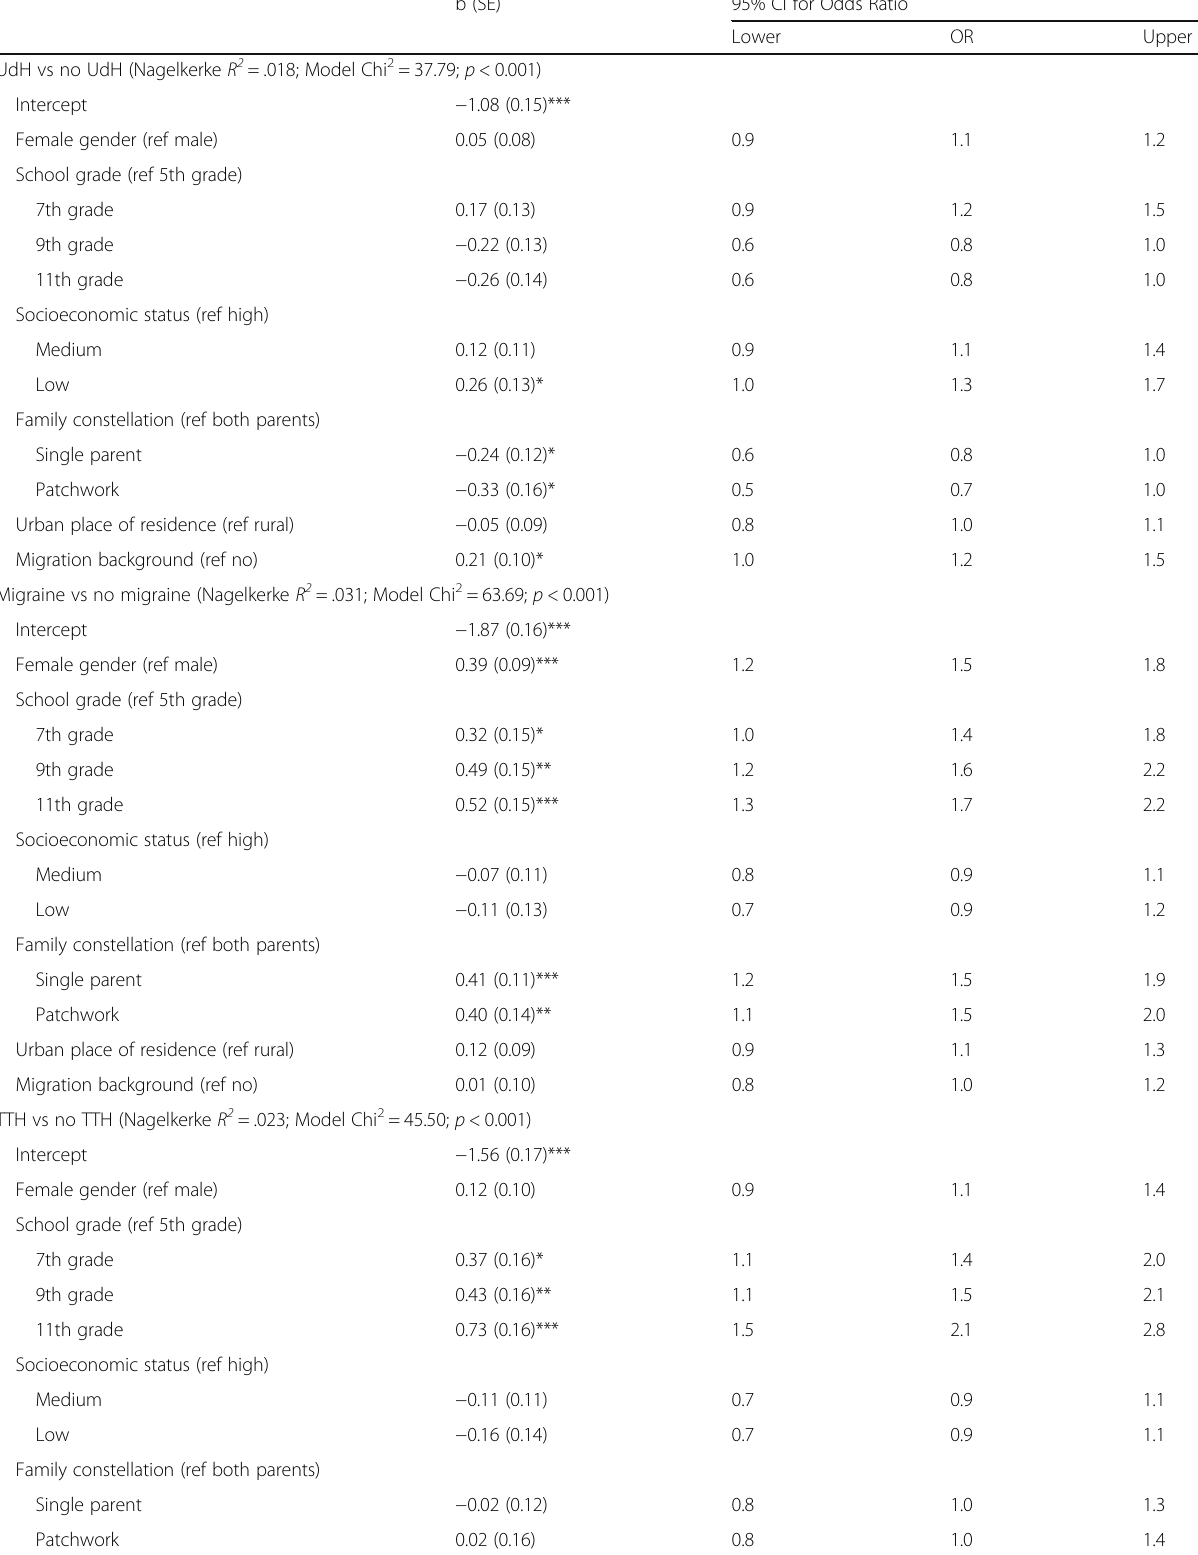
Table 4 Logistic regression analyses of sociodemographic associations with headache